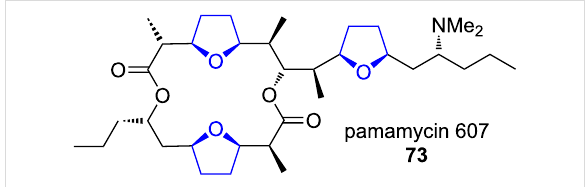
Figure 2: Pamamycins ( 73 ) are macrodiolide antibiotics containing three tetrahydrofuran moieties, which are all proposed to be formed by the NonS homolog PamS